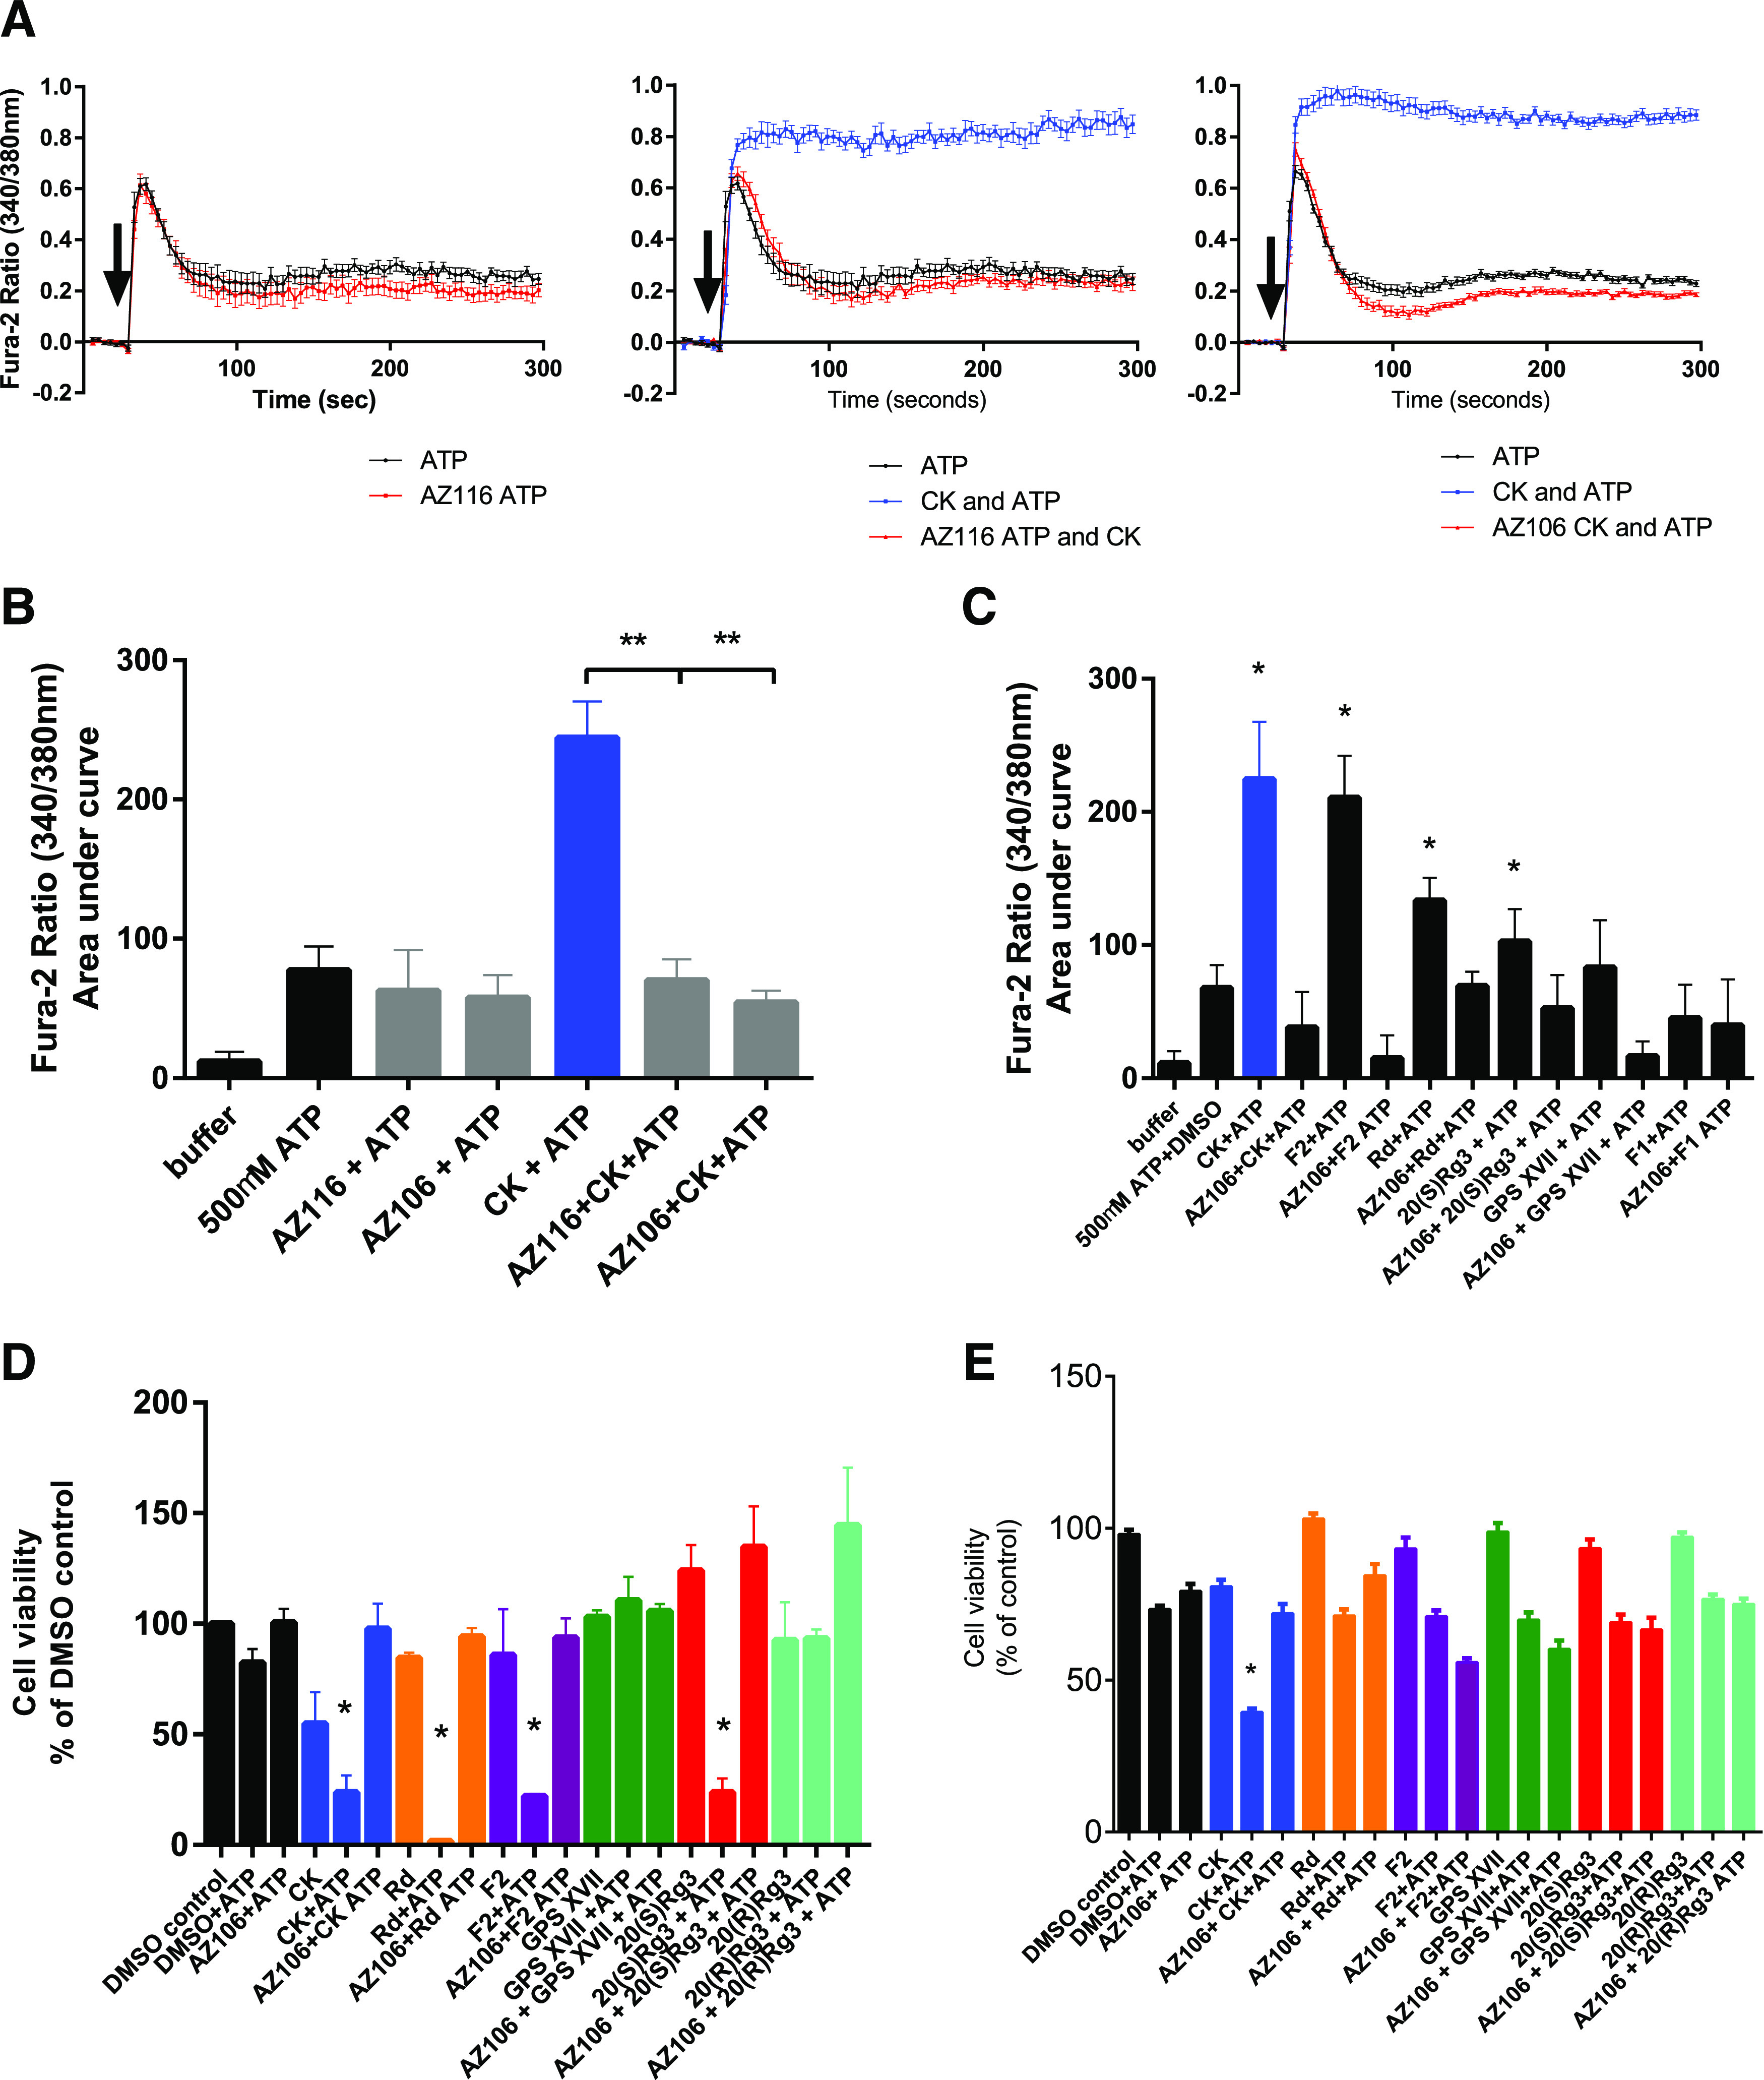
The PAM effects of glycosides in human THP-1 monocyte cell line. (A) ATP-induced calcium responses were measured in fura-2 AM loaded THP-1 cells in suspension using a Flexstation 3 plate reader. Agonist (500 µM ATP) and PAM (ginsenoside-CK 10 µM) were coinjected after establishment of a baseline for 40 seconds. Cells were preincubated with various P2X7 antagonists for 10 minutes prior to start of plate recordings. (B) Summary of collated data from calcium measurements. Fura-2 responses were calculated as area under curve. Data were analyzed using one-way ANOVA with Tukey’s multiple comparisons test to assess the effect of antagonists. *P < 0.05. (C) Investigating the P2X7 dependence of glycoside effects on ATP-induced calcium responses. AZ10606120 (AZ106; 10 µM) was added to cells to block P2X7 receptors prior to measuring calcium responses. Data were analyzed using one-way ANOVA with Dunnett’s multiple comparison test comparing each column against the control (500 µM ATP + DMSO). *P < 0.05. (D) Cell viability experiments were performed over 24 hours using HEK-hP2X7 cell line. Alamar blue fluorescence was measured, and data were normalized to percentage of control (DMSO). Data were collated from five independent experiments. One-way ANOVA was used to analyze the data with Sidak’s multiple comparisons test to compare selected pairs of columns (DMSO + ATP vs. ginsenoside + ATP). *P < 0.05. (E) Cell viability experiments were performed over 24 hours using THP-1 cells. Alamar blue fluorescence was measured and data were normalized to percentage of control (DMSO). Data were collated from five independent experiments. One-way ANOVA was used to analyze the data with Sidak’s multiple comparisons test to compare selected pairs of columns (DMSO + ATP vs. ginsenoside + ATP). *P < 0.05.